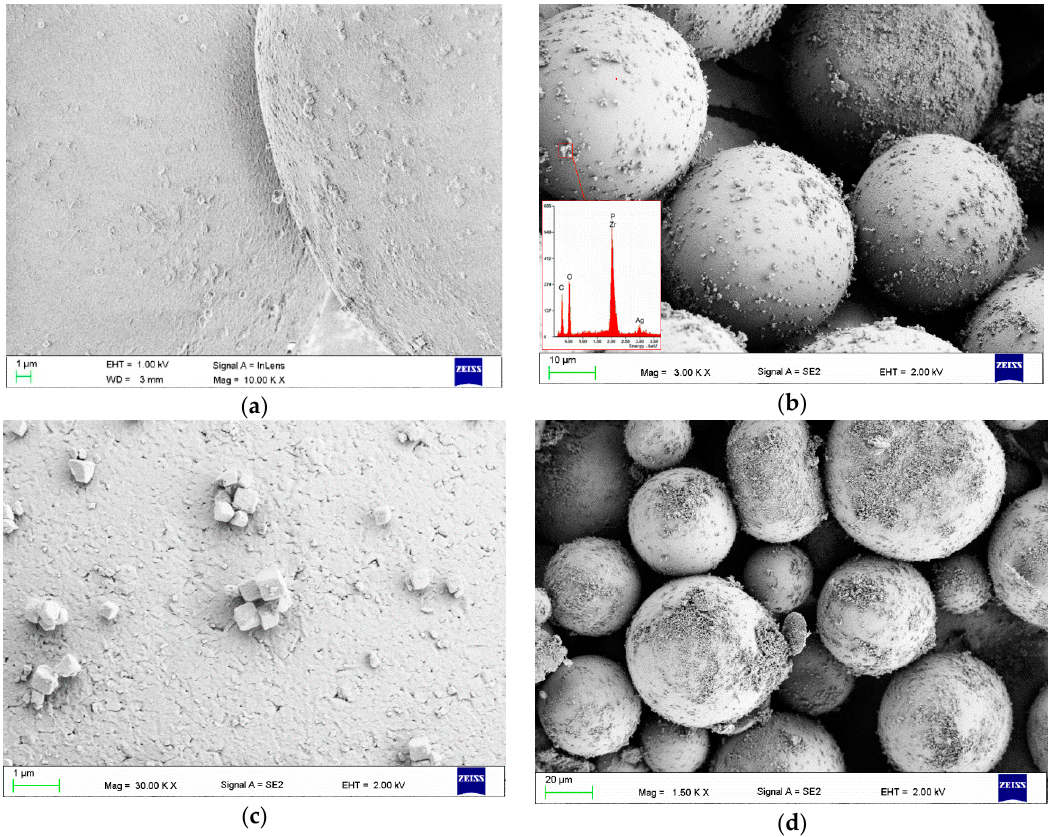
Figure 2. Representative SEM images presenting the surface of the PMMA spheres after filler introduction: ( a ) sphere surface after milling with 0.25% filler; ( b ) surfaces of spheres with 2% filler and the corresponding energy-dispersive X-ray spectroscopy (EDS) spectrum, which confirmed the presence of zirconium, phosphorus and silver; ( c ) smaller aggregates of filler particles; ( d ) spheres covered to a large extent by filler particles when 4% filler was introduced.